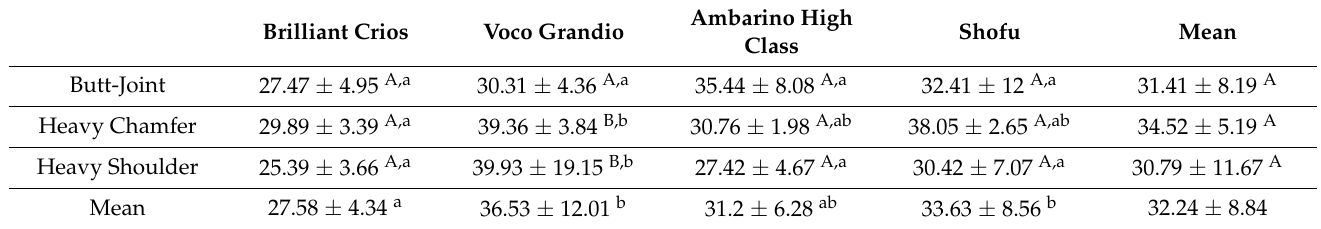
Table 2. Values and standard deviations of marginal gap for test groups ( µ